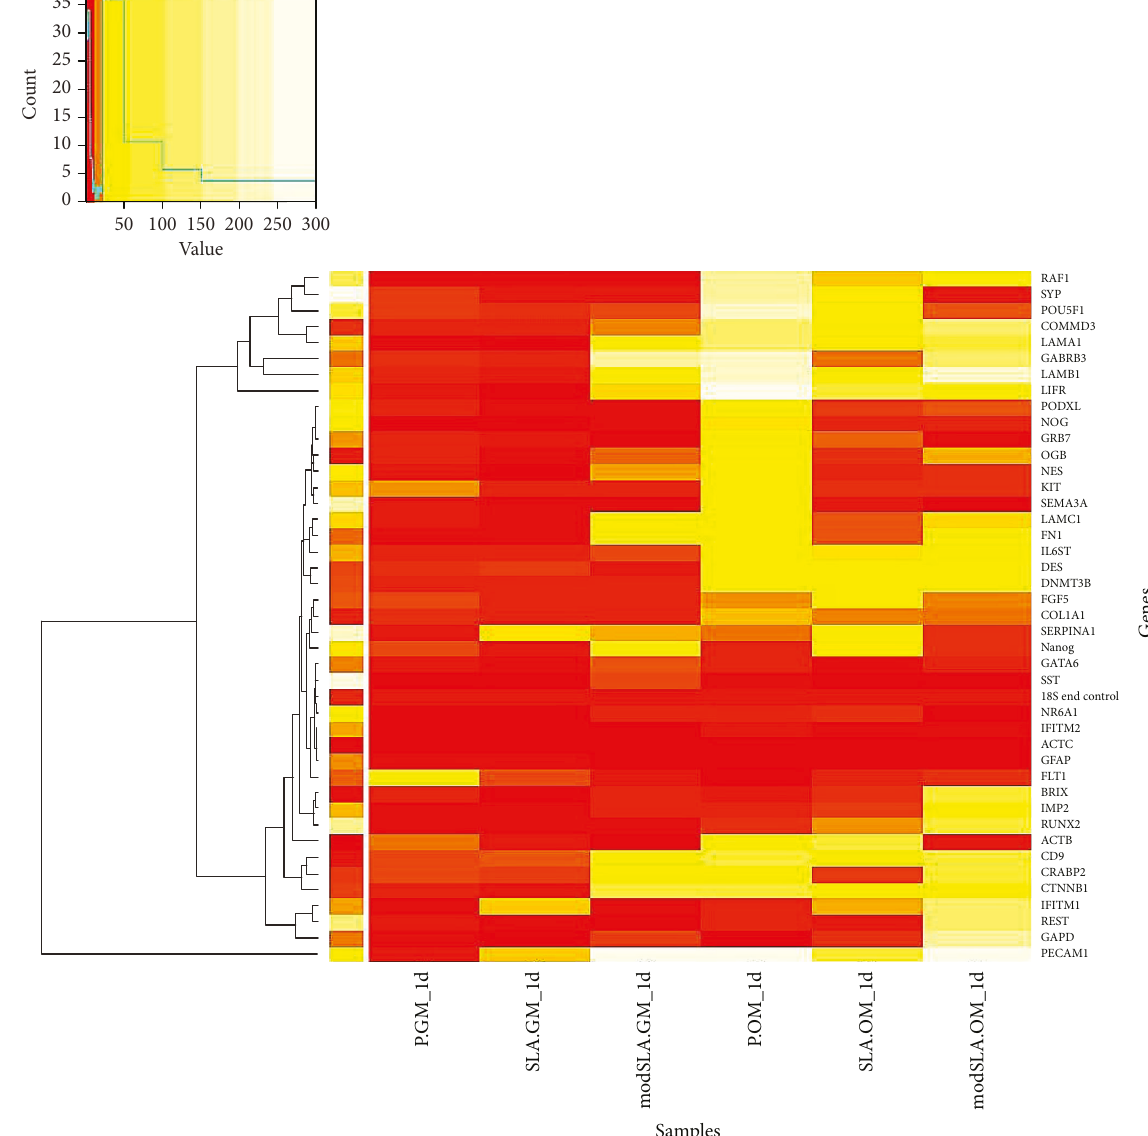
Figure 6: Analysis of pluripotency gene expression arrays in MSCs after 24 h. A heatmap of cumulative values of fold expression represented by the minimum ( red = 0 ) to the maximum ( white = 300 ). Cumulative values; N = 3 , n = 1 Table 2 indicates di ff erent gene transcription pro fi les for MSCs cultured on the SLA and modSLA Ti surfaces with the latter signi fi cantly increasing the expression of genes key to pluripotency, stemness, and di ff erentiation